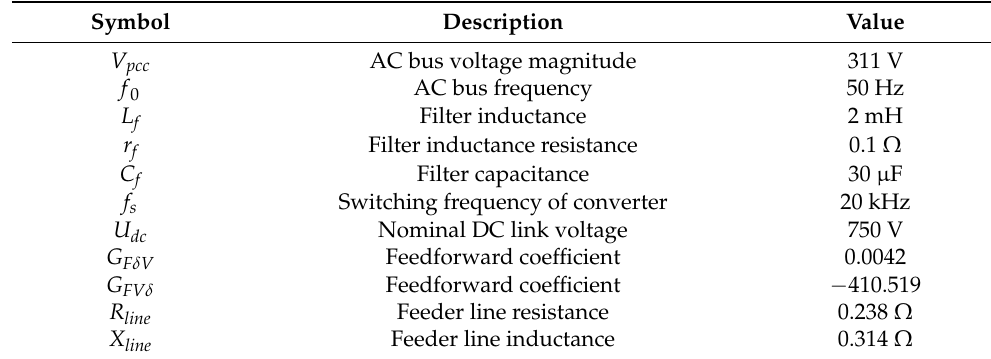
Table 1. Main parameters of the system for Case A.